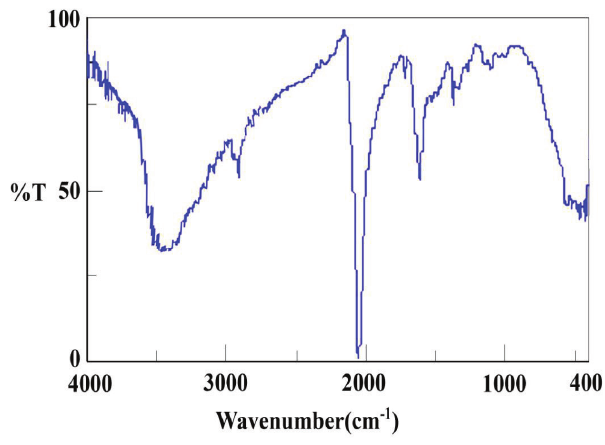
Fig. 3. FT-IR spectrum of (BMIM)